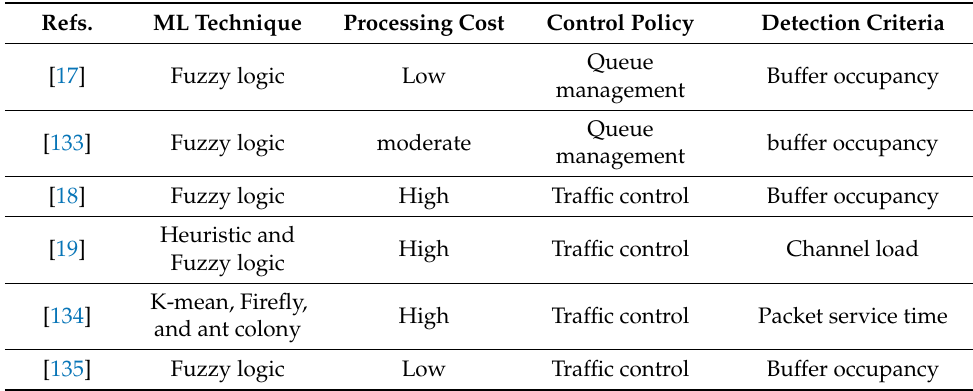
Table 6. Summary of reviewed ML algorithms in congestion control.